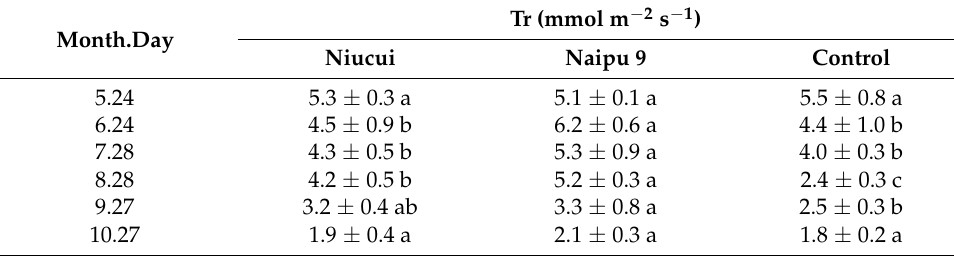
Table 8. Effects of spraying calcium fertilizer on transpiration rate (Tr) of apple leaves. Month.Day